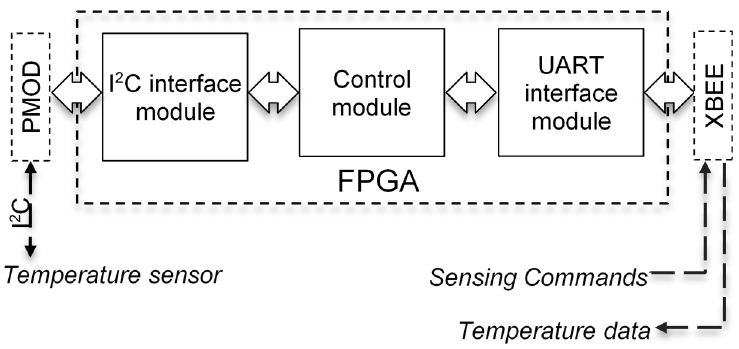
Figure 5. Block diagram of temperature-sensing logic.